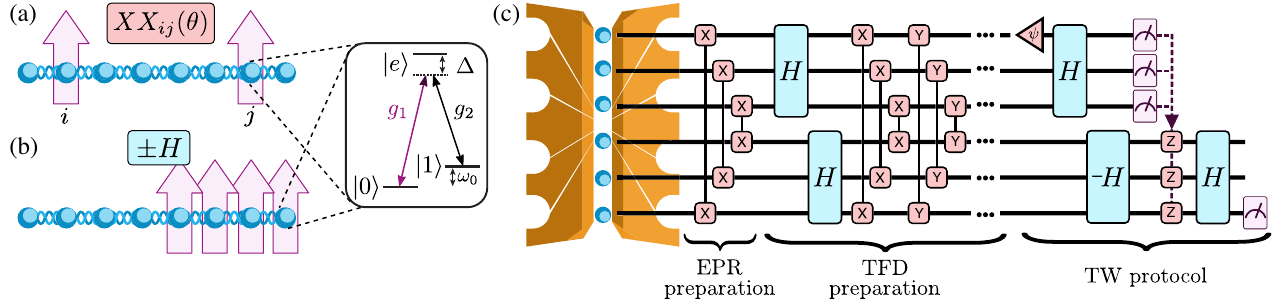
FIG. 9. (a),(b) Chain of atomic ions, with qubit states j 0 i and j 1 i represented by hyperfine ground states. The states are coupled by a pair of laser beams, one with individual addressing (with strength g 1 , purple) and one applied globally (with strength g 2 ). Each beam is strongly detuned from an excited state j e i by an amount Δ . The coherent beat note between the beams, at frequency ω 0 , drives stimulated Raman transitions between the qubit levels with an effective Rabi frequency g 1 g 2 = 2 Δ and also modulates the Coulomb interaction between qubits to give rise to an effective Ising interaction. (a) A two-qubit entangling gate, XX performed by addressing only ions i and j with the first beam. (b) Half of the qubits are addressed, which leads to analog time evolution under the Hamiltonian Eq. (105) (blue) for all addressed spins. (c) Quantum circuit implementation of the teleportation protocol at finite temperature. EPR pairs are formed using two-qubit gates. The TFD state is then prepared via a QAOA approach by iterating multiple times between two-qubit gates coupling the sides and analog time evolution on both sides individually [91,92]. The state j ψ i is inserted either by projectively measuring the designated qubit and preparing the state or by digitally swapping in an additional qubit (not shown). Finally, teleportation is implemented using similar ingredients as well as feed-forward measurements (purple dotted